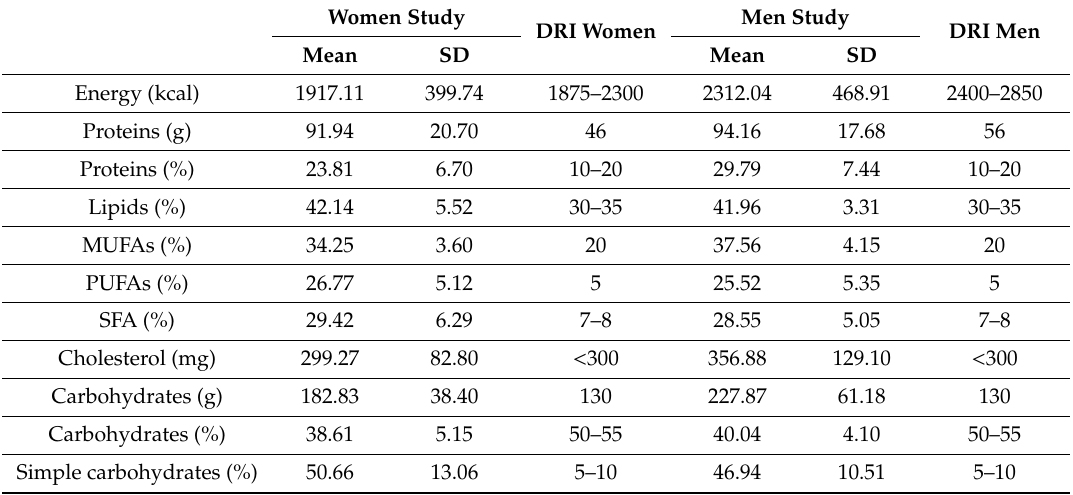
Table 2. Description of eating habits and daily calorie intake of the population of the